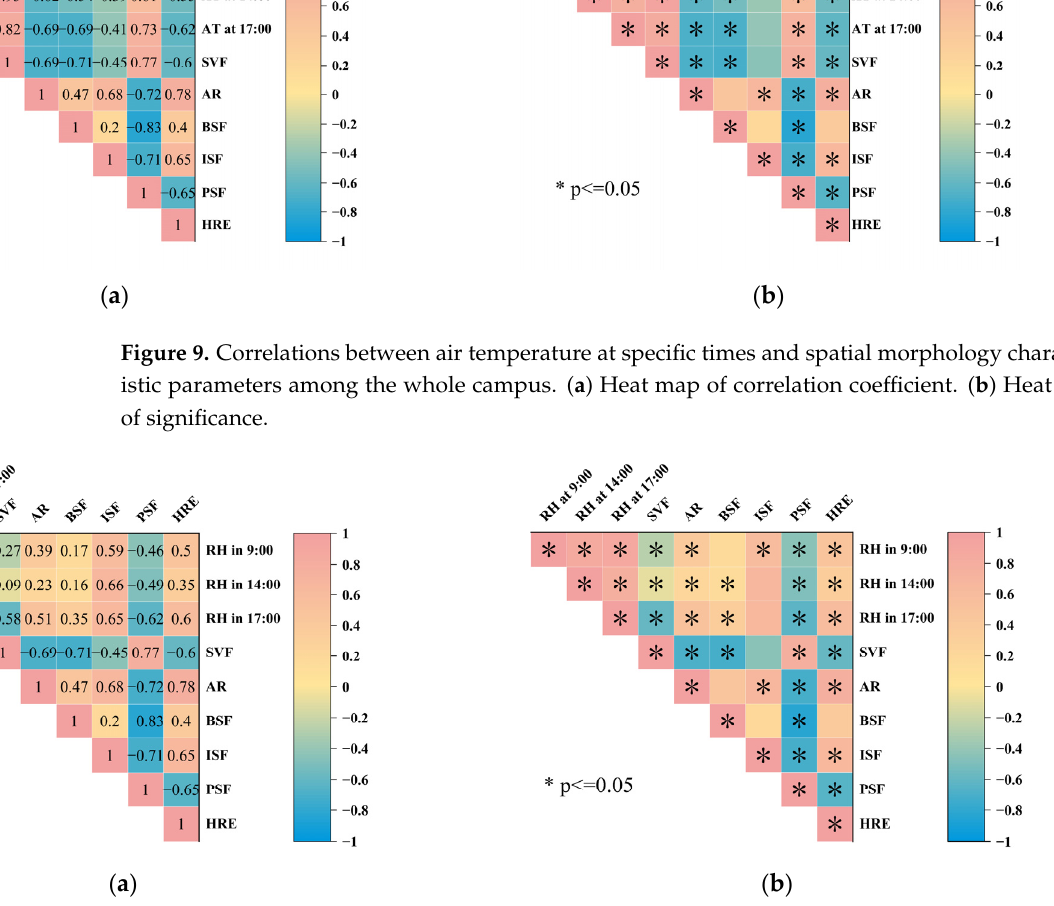
Figure 10. Correlations between relative humidity at specific times and spatial morphology charac- teristic parameters among the whole campus. ( a ) Heat map of correlation coefficient. ( b ) Heat map of significance.